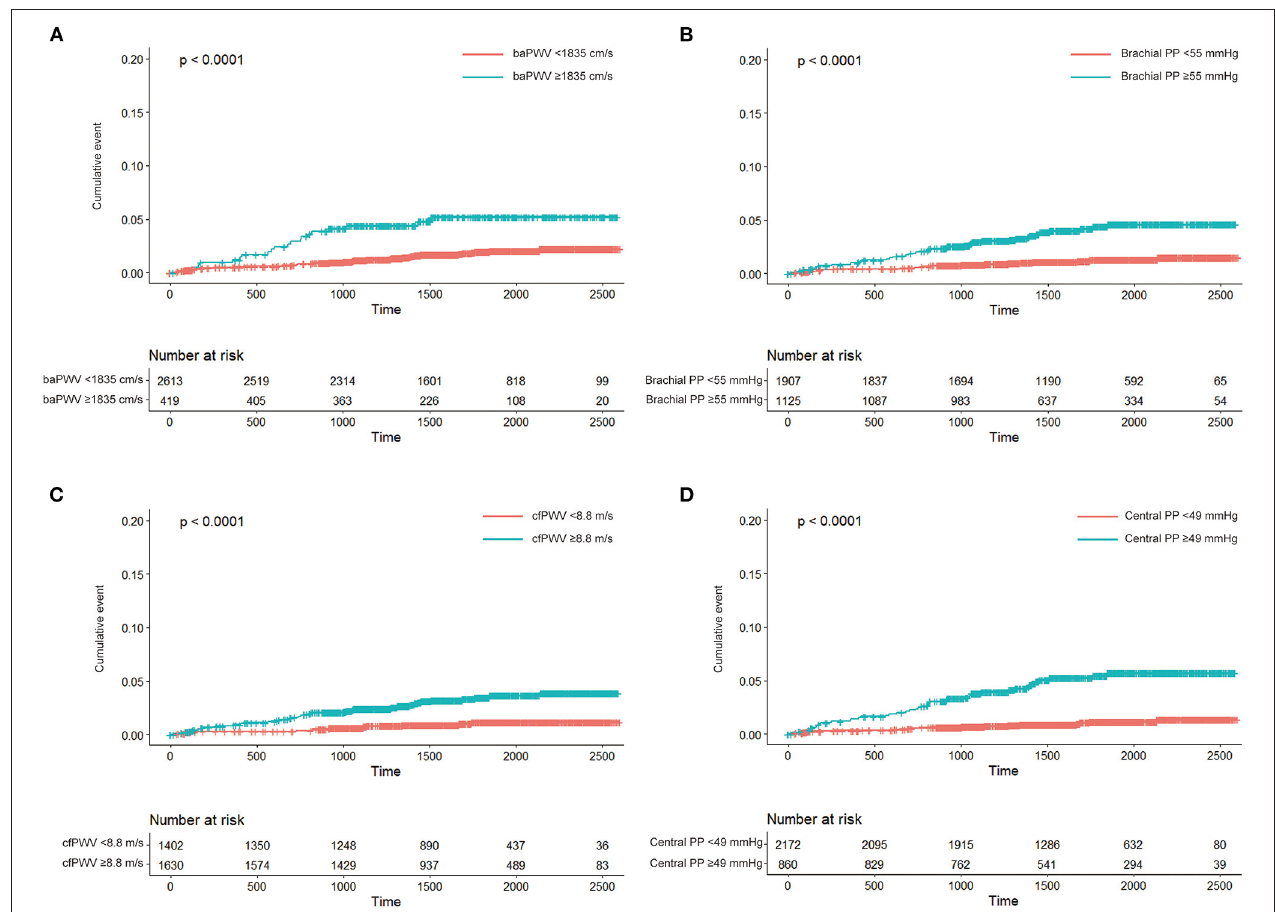
FIGURE 2 | Kaplan-Meier curve analyses of cumulative incidence of heart failure according to high-risk category of brachial-ankle pulse wave velocity (baPWV; A ), brachial pulse pressure (brachial PP; B ), carotid-femoral pulse wave velocity (cfPWV; C ), and central pulse pressure (central PP; D ).